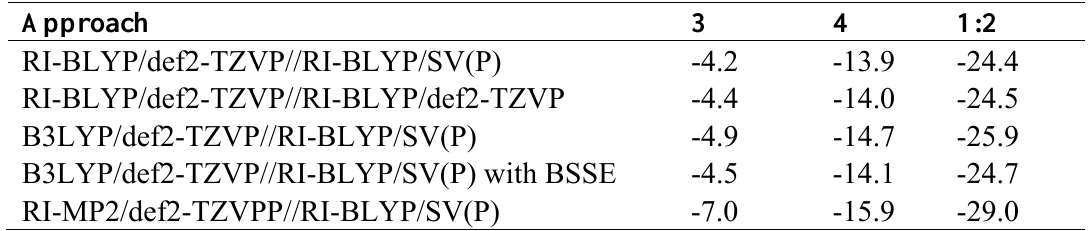
Table 3. A comparison of the obtained binding energies between various theoretical approaches for two selected 1:1 complexes and the most stable 1:2 complex between nia and